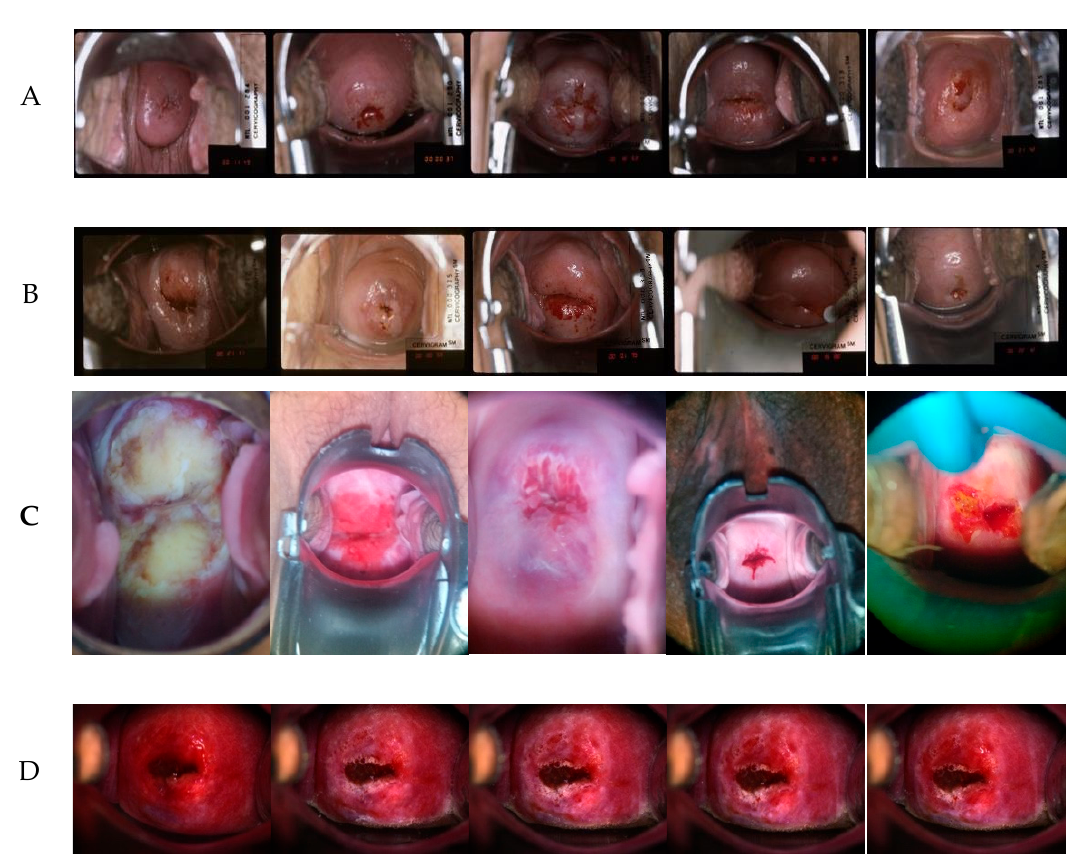
Figure 1. Example images from the above four datasets. The 1st row demonstrates the CVT ( A ) dataset; the 2nd row shows samples from the ATLS ( B ) dataset; Kaggle ( C ) images are presented in the 3rd row; and images from the DYSIS ( D ) dataset are provided in the 4th row; the frame indexes are 1st, 4th, 8th, 13th, and 17th in the time sequence, from left to right, correspondingly.